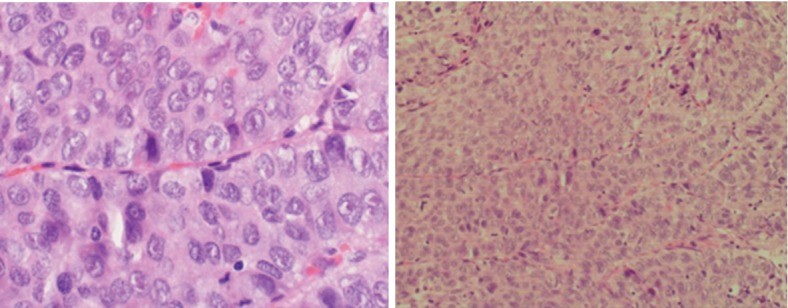
A biopsy showing frequent mitotic figures, pleomorphism, and vesicular nuclei with ill-defined infiltrate in the right lower zone.